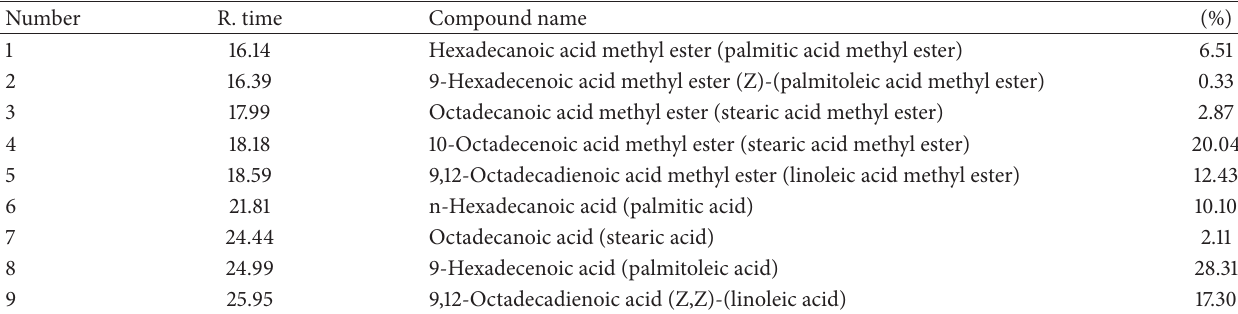
Table 1: Antimicrobial compounds, retention times, and percentages of methanol leaf extract of Jatropha curcas analyzed by a gas chromatography-mass spectrometry.